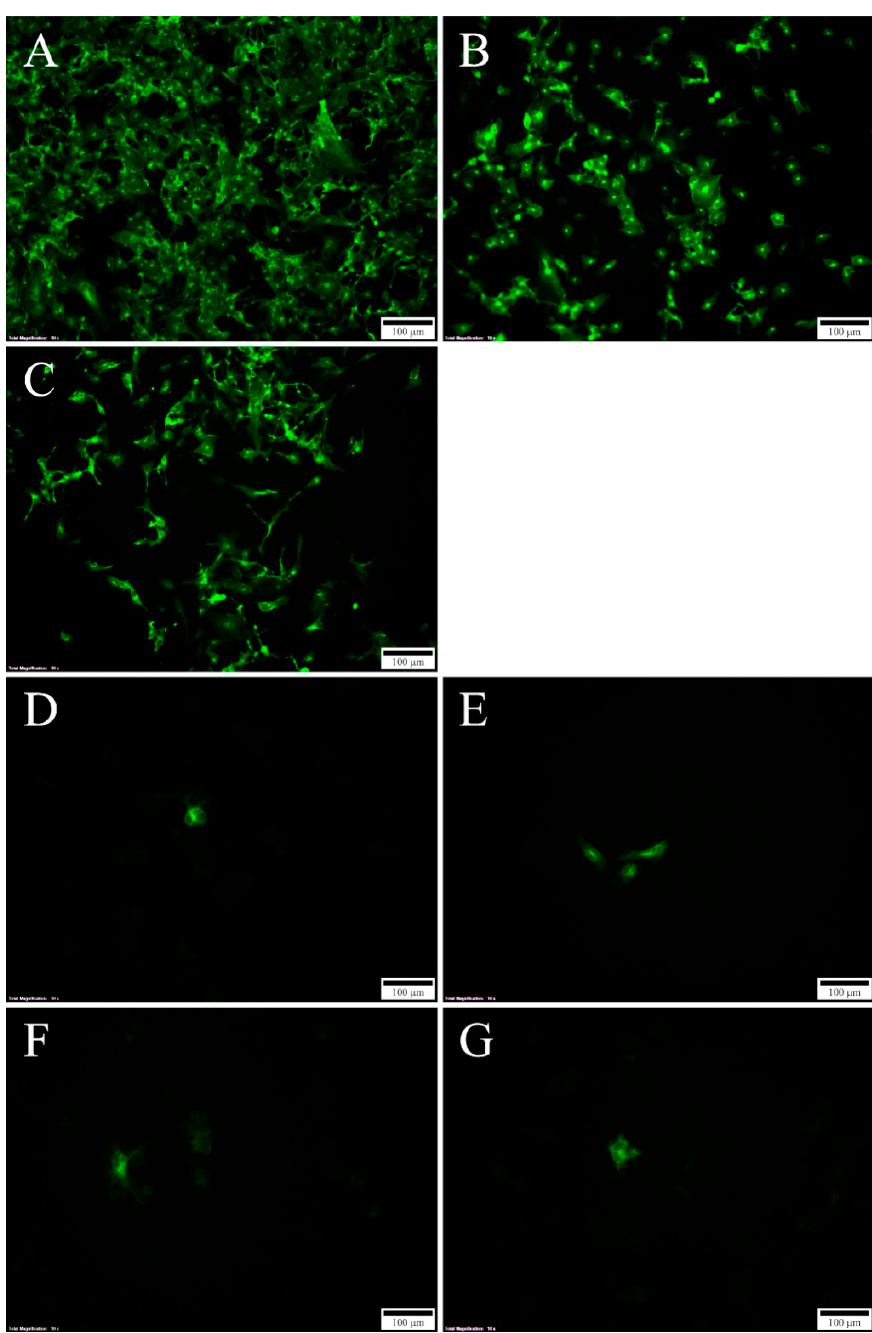
Figure 4. IFAT targeting E2 in CHSE-214 cells: 7 dpt, 10X; ( A ) rSAV3; ( B ) rSAV3 E2 319Q ; ( C ) rSAV3 E2 319A ; ( D ) rSAV3 E1 35Q ; ( E ) rSAV3 E1 35A ; ( F ) rSAV3 E1 35Q E2 319Q; and ( G ) rSAV3 E1 35A E2 319A . Strong staining in cells transfected with the rSAV3 clone and the two constructs containing mutations in E2 319 only ( A – C ). Weak or no staining in cells transfected with constructs containing mutations in E1 35 ( D – G ).